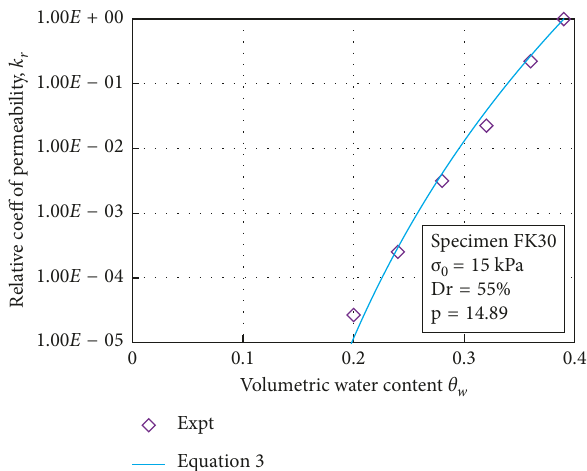
Figure 14: Permeability changes against volumetric water content for FK30 soils.